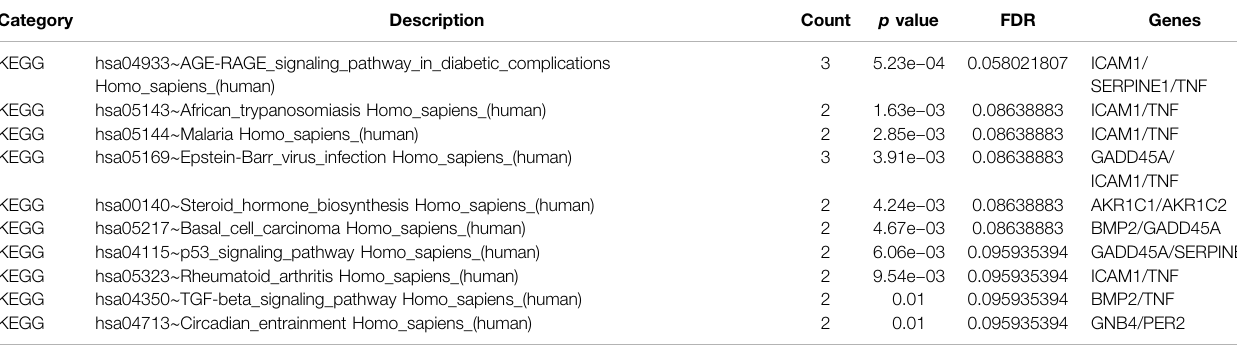
TABLE 4 | KEGG pathway analysis of differentially expressed genes in ESCC.